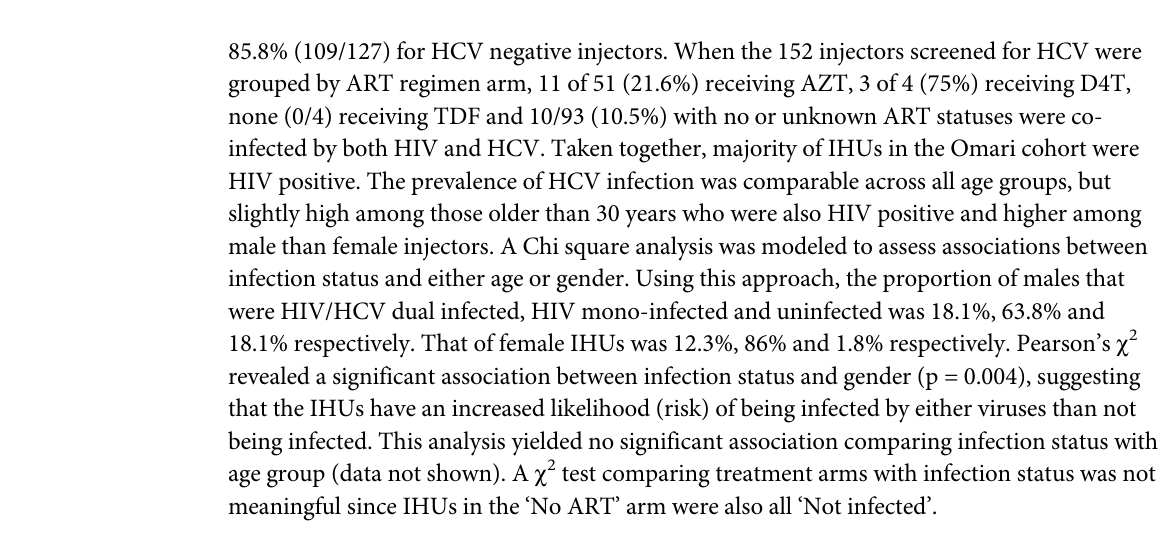
85.8% (109/127) for HCV negative injectors. When the 152 injectors screened for HCV were grouped by ART regimen arm, 11 of 51 (21.6%) receiving AZT, 3 of 4 (75%) receiving D4T, none (0/4) receiving TDF and 10/93 (10.5%) with no or unknown ART statuses were co- infected by both HIV and HCV. Taken together, majority of IHUs in the Omari cohort were HIV positive. The prevalence of HCV infection was comparable across all age groups, but slightly high among those older than 30 years who were also HIV positive and higher among male than female injectors. A Chi square analysis was modeled to assess associations between infection status and either age or gender. Using this approach, the proportion of males that were HIV/HCV dual infected, HIV mono-infected and uninfected was 18.1%, 63.8% and 18.1% respectively. That of female IHUs was 12.3%, 86% and 1.8% respectively. Pearson ’ s χ 2 revealed a significant association between infection status and gender (p = 0.004), suggesting that the IHUs have an increased likelihood (risk) of being infected by either viruses than not being infected. This analysis yielded no significant association comparing infection status with age group (data not shown). A χ 2 test comparing treatment arms with infection status was not meaningful since IHUs in the ‘ No ART ’ arm were also all ‘ Not infected ’ .